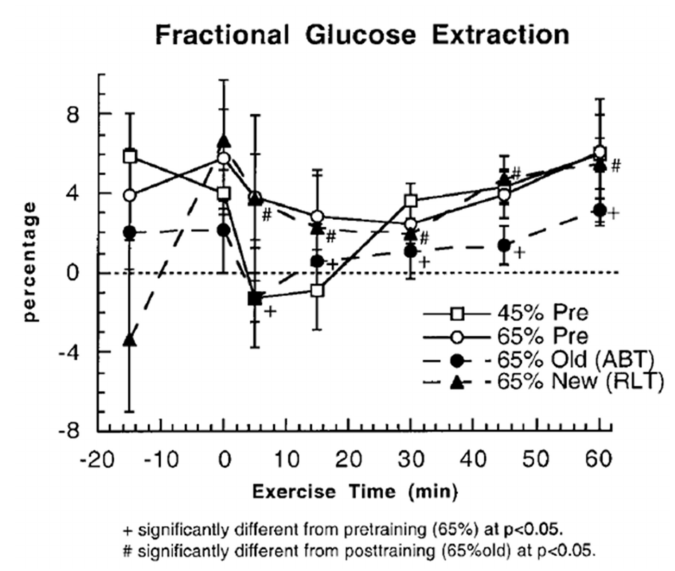
Figure 5. Fractional glucose extractions (%) determined from arterial-venous concentration di ff erences (a–v) in resting and exercising young men, before and after endurance training. Subjects were studied at 45 and 65% of peak rate of oxygen consumption (VO 2 peak) before 9 week of endurance training (45% pre and 65% pre, respectively) and then after training at same absolute power output that elicited 65% VO 2 peak before training (65% old (absolute, ABT)) and same relative power output that elicited 65% VO 2 peak after training (65% new (relative, RLT)). Values are means ± SE; n = 6–8, same subjects as in Figures 3 and 4, but show variability due to variances around measuring arterial and venous blood glucose values. There does not appear to be a training-induced increase in resting or working muscle glucose fractional extraction. From [10].